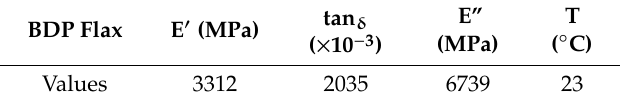
Table 6. Results regarding the analysis in the dynamic regime of the Extrudr BDP Flax